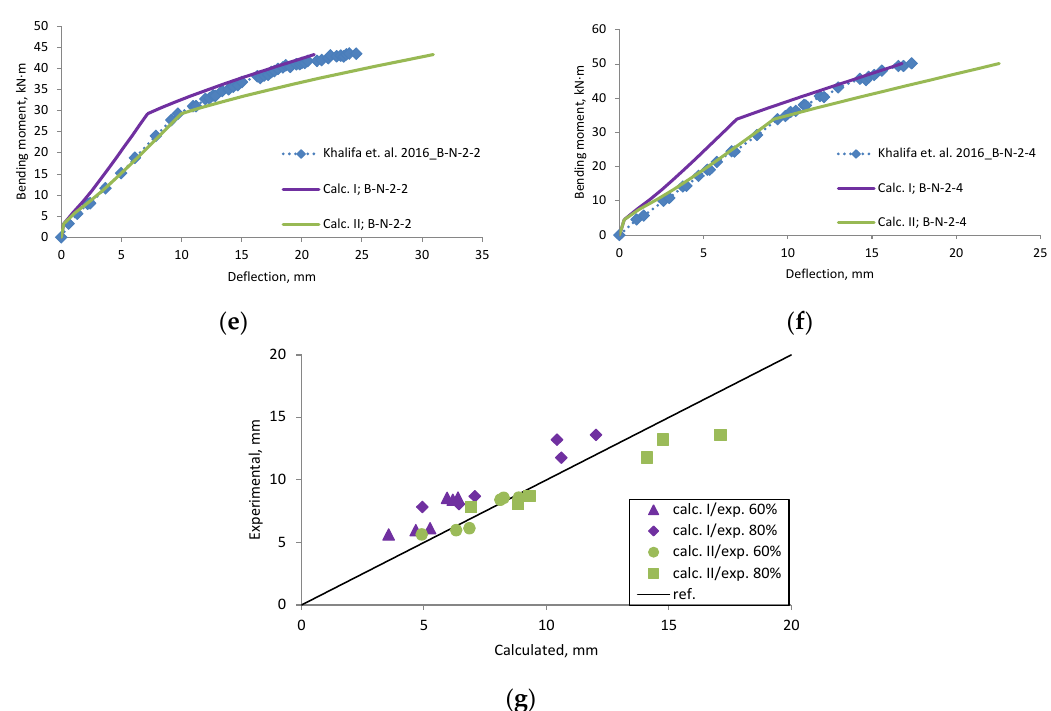
Figure A11. Khalifa et al., 2016 [34] research beams deflection compared with calculated, ( a ) beam B-C; ( b ) beam B-S-2; ( c ) beam B-S-4; ( d ) beam B-N-1-2; ( e ) beam B-N-2-2; ( f ) beam B-N-2-4; ( g ) scatter of the results at 60% and 80% of the ultimate load.